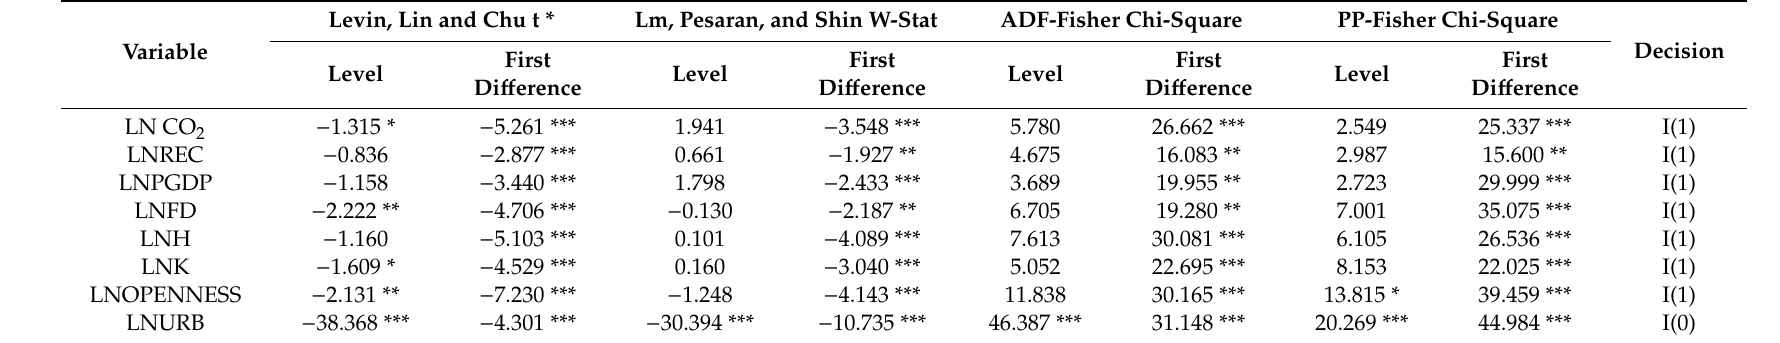
Table 6. Unit root tests results